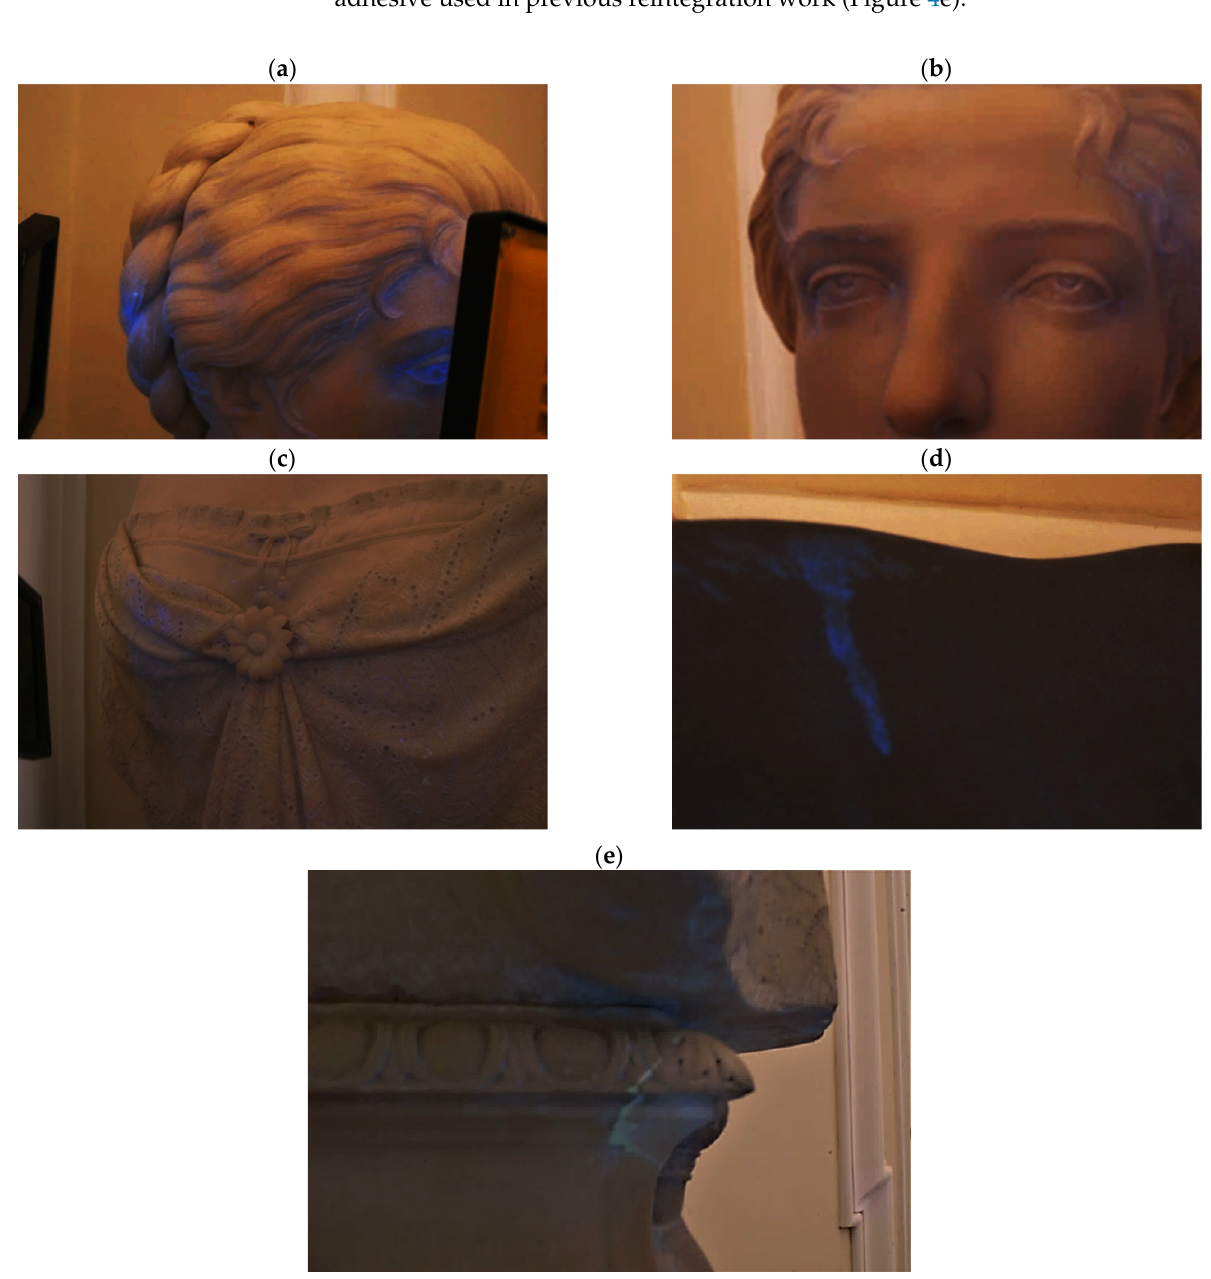
Figure 4. Details of visible induced fluorescence areas under UV light. ( a ) Head: Hair and eye. UV fluorescence of calcite polymorphs; ( b ) Head: face area. UV fluorescence of calcite polymorphs; ( c ) Body: drippings. UV fluorescence; ( d ) Back: drippings. UV fluorescence; ( e ) Base: adhesive UV fluorescence.